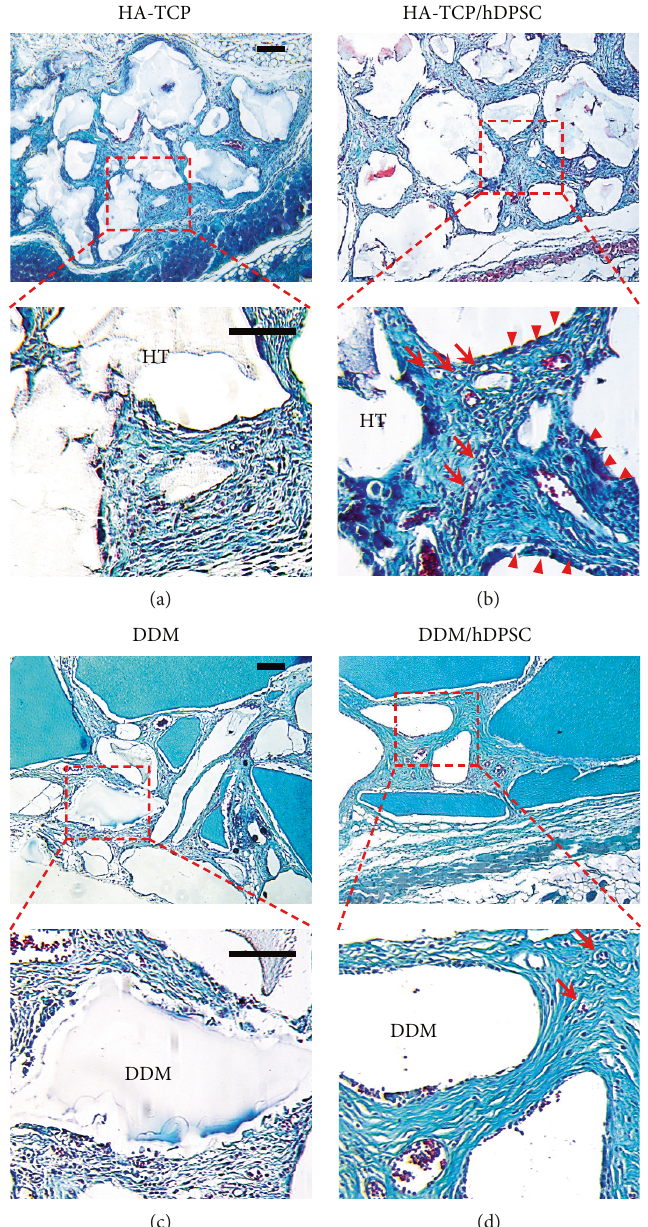
Figure 6: Histological analysis of bone-like tissue formed in transplants. Bone formation in vivo in athymic nude mice was examined by Goldner ’ s trichrome staining of para ffi n sections of transplants. (a) Transplants of HA-TCP only. (b) Transplants of HA-TCP with hDPSCs. (c) Transplants of DDM only. (d) Transplants of DDM with hDPSCs. Osteoid and lacuna structures were indicated as arrow heads ( ► ) and arrows ( → ), respectively. Scale bar: 100 μ